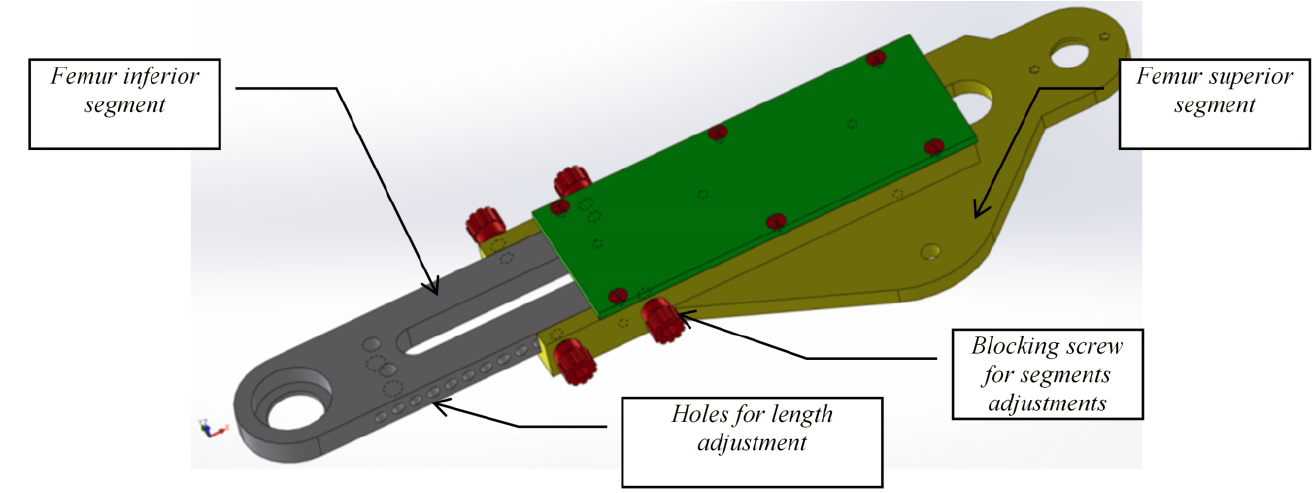
Figure 19. Femur segment with variable length.